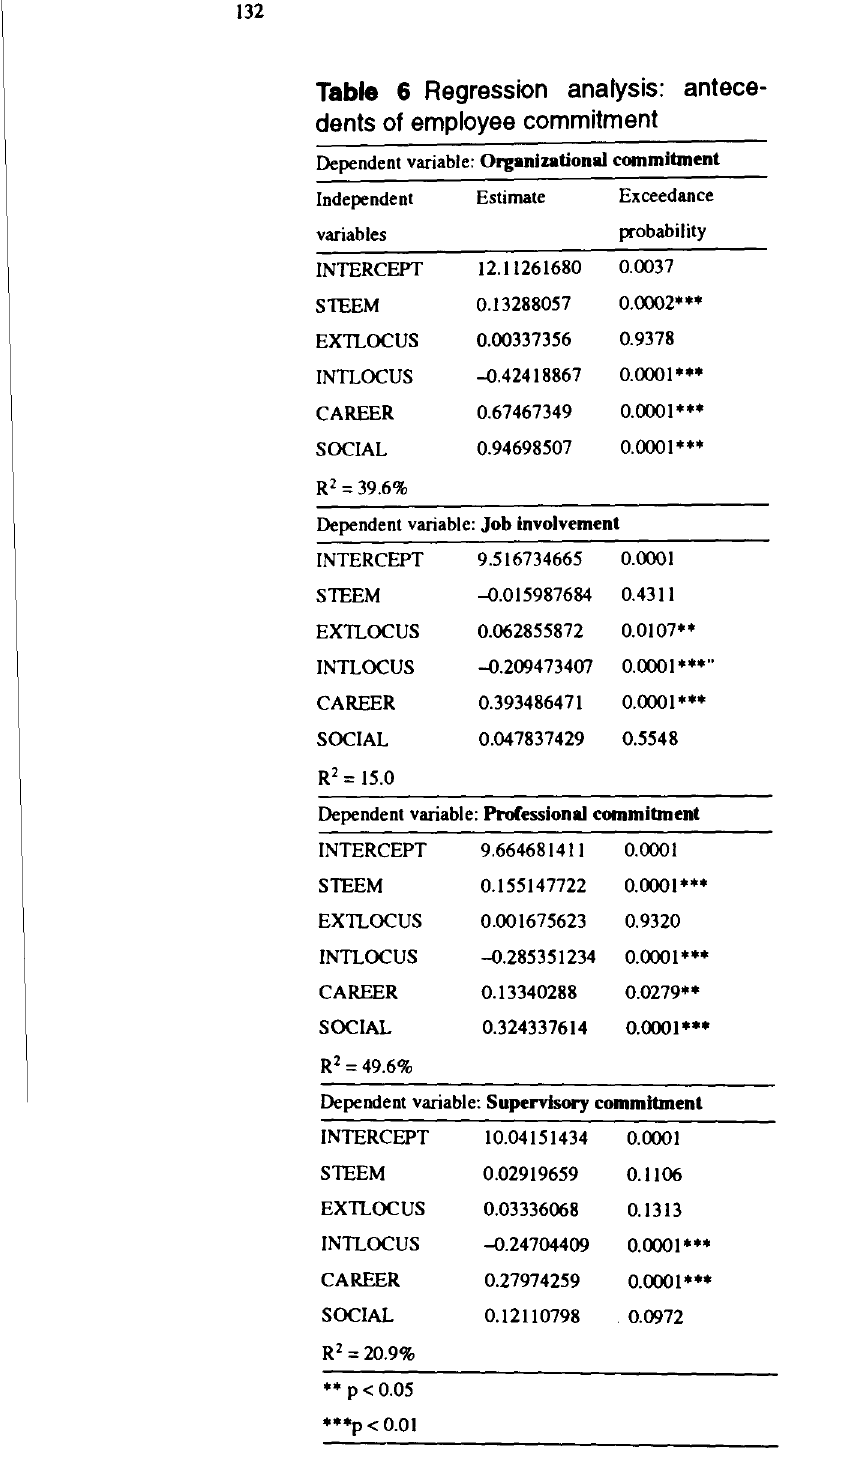
Table 6 Regression analysis: antece dents of employee